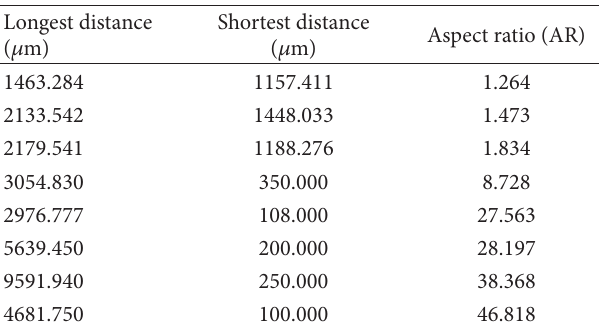
T 6: Aspect ratios of different non-oily POME �bres. Longest distance